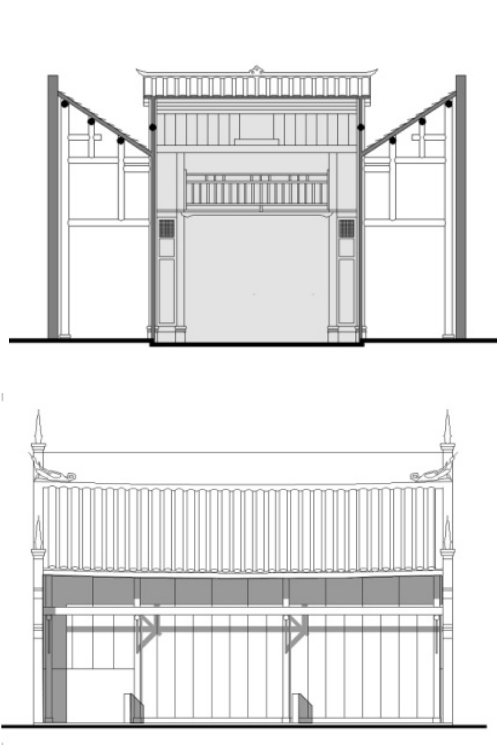
Figure 31. Zhai, S.B. House elevation and